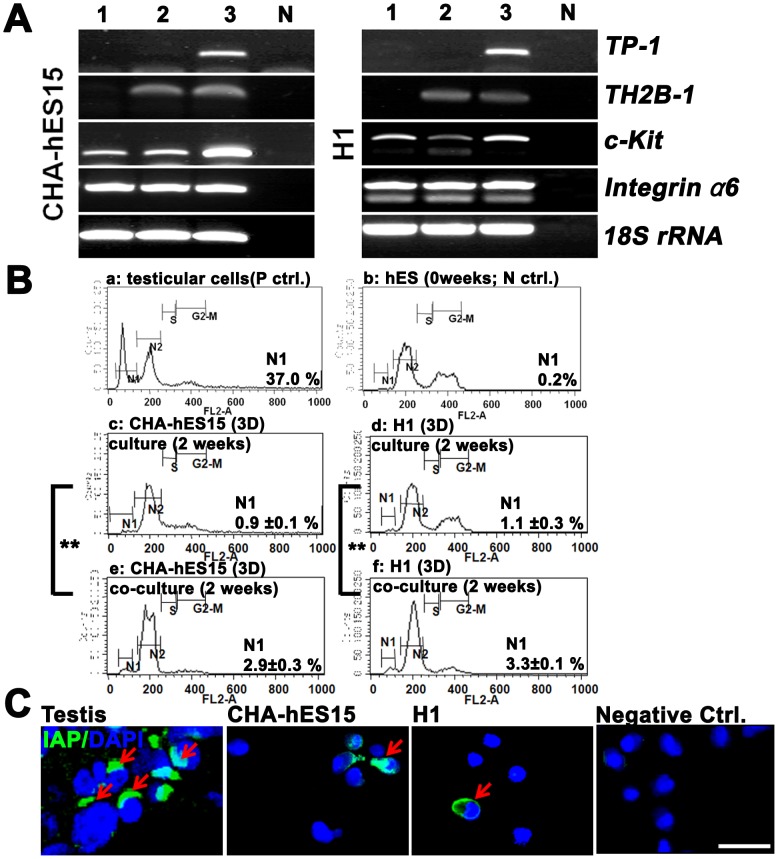

In vitro culture of GSC-like cells using a 3D-co-culture system and the potential for differentiation into germ cell lineages.(A) Expression of stage-specific genes (integrin α6, c-Kit, TH2B and TP-1) during in vitro differentiation of human ESC-derived GSC-like cells using RT-PCR. Integrin α6 (undifferentiated spermatogonia), c-Kit and TH2B (differentiating spermatogonia and spermatocytes), TP-1 (meiotic spermatocytes and spermatids) were used as stage-specific germ cell marker genes. 18S ribosomal RNA was used as a control gene. Line 1–3: ESC-derived GSC-like cells (0, 1, and 2-week culture in the 3D-co-culture system), N: no reverse transcriptase. (B) DNA content of in vitro differentiated ESC-derived GSC-like cells. a; DNA content of cells from obstructive azoospermia (OA, normal spermatogenesis sample) b; Undifferentiated human embryonic stem cells (CHA-hES15). N1 represents haploid germ cells and N2 represents diploid cells. (C) Localization of intra acrosomal protein (IAP) in human testes (upper panel) and in vitro differentiated GSC-like cells from hESCs (middle and lower figure). IAP was stained in spermatid acrosomes. The yellow arrows indicate fluorescence signals. Note: **; significantly different (p<0.05). Scale bars: 50 µm.